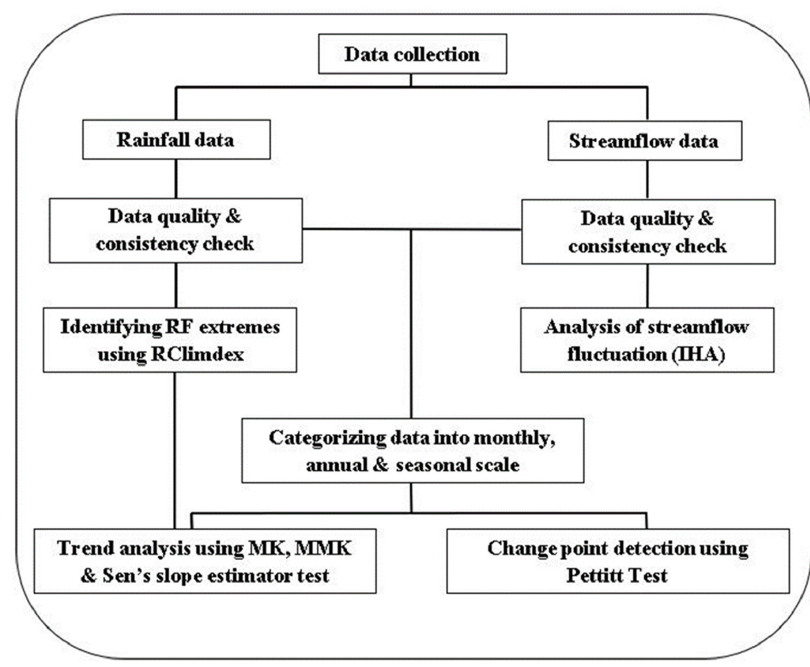
Figure 2. Overall methodology.